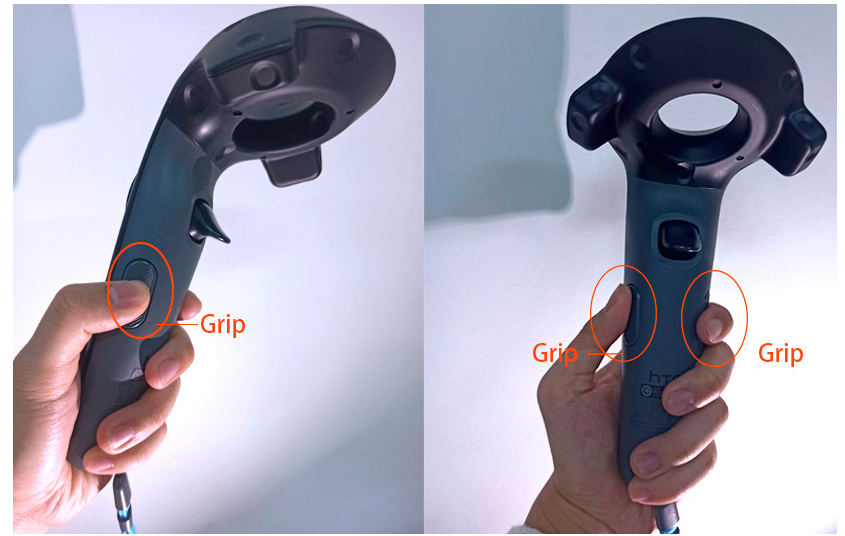
Figure 5. Using the grip key of the HTC Vive handle as the climbing grip key.